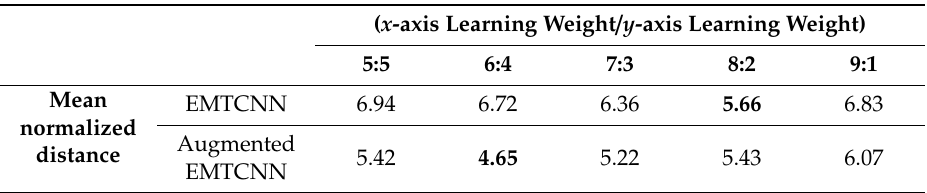
Table 5. Comparison of extraction accuracy depending on